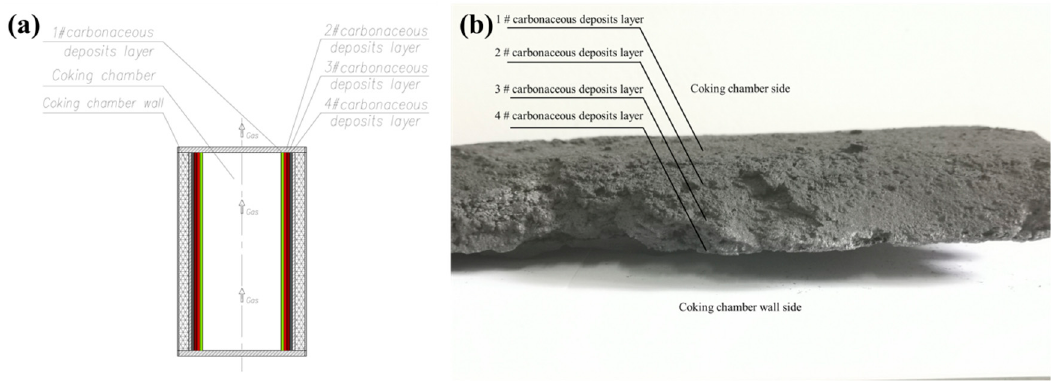
Figure 2. Distribution of each carbonaceous deposit layers: ( a ) schematic diagram; ( b ) digital photo.